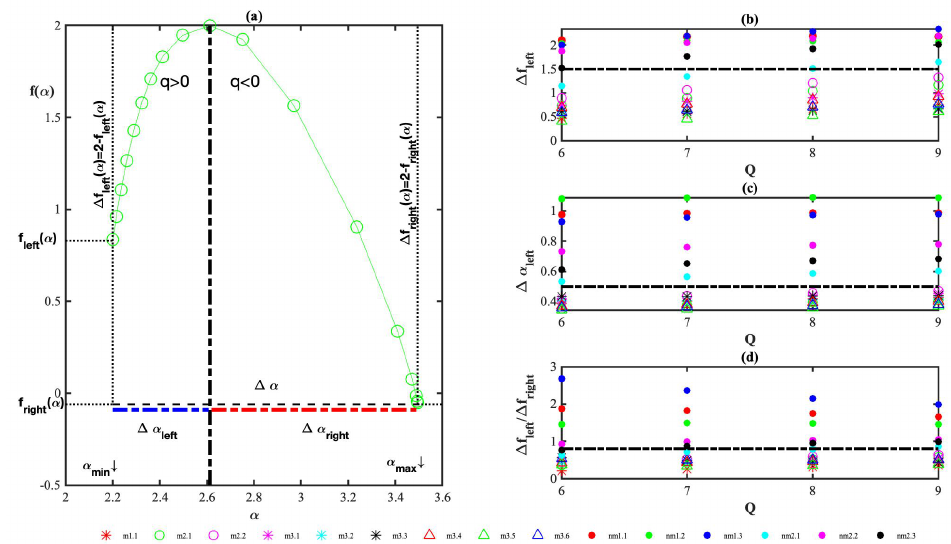
Figure 2. ( a ) Definition/visualization of the measures ∆ α , ∆ α i , ∆ f i ( i = left / right ) used to investigate multifractal spectrum asymmetry as well the singularity parameter asymmetry. The multifractal spectrum of the sample m2.1 was used for the definitions. The multifractal spectrum of NM samples is illustrated in Figure A1d; ( b ) width of multifractal spectrum to the left, ∆ f left ; ( c ) singularity parameter to the left, ∆ α left ; and ( d ) ratio of singularity parameters to the left/right, ∆ f left / ∆ f right . In all graphs, Q stands for the maximum moment. Calculations were carried out for q in the range [-Q-1,Q+1]. The numbering of the samples is determined by an alphanumeric sequence whose first letter determines the assessment of the histopathologists by optical microscope, m/nm for metastatic/non-metastatic. The first number identifies the patient and the number after the dot the sample number, e.g., m1.2, means that the second sample of the first patient is metastatic. The singularity parameters ∆ f i , i = le f t / right characterize the broadness of the spectrum and their ratio, ∆ f left / ∆ f right is a direct measure of the depth of the spectrum tail. If ∆ f left / ∆ f right > 1, the left-hand side is deeper (for q > 0) and implies strong singularities, while for ∆ f left / ∆ f right < 1, the tail for q < 0 is deeper, implying weak singularities. If the spectrum was symmetric on both axes, then ∆ α left = ∆ α right and ∆ f left = ∆ f right would hold true. For ∆ α left > ∆ α right and ∆ f left > ∆ f right , the spectrum is skewed to the left, and it is skewed right otherwise. Figures 2(b),(c),(d), show three measures that in principle can differentiate M from NM histological cross-sections. Every single point depicted in these